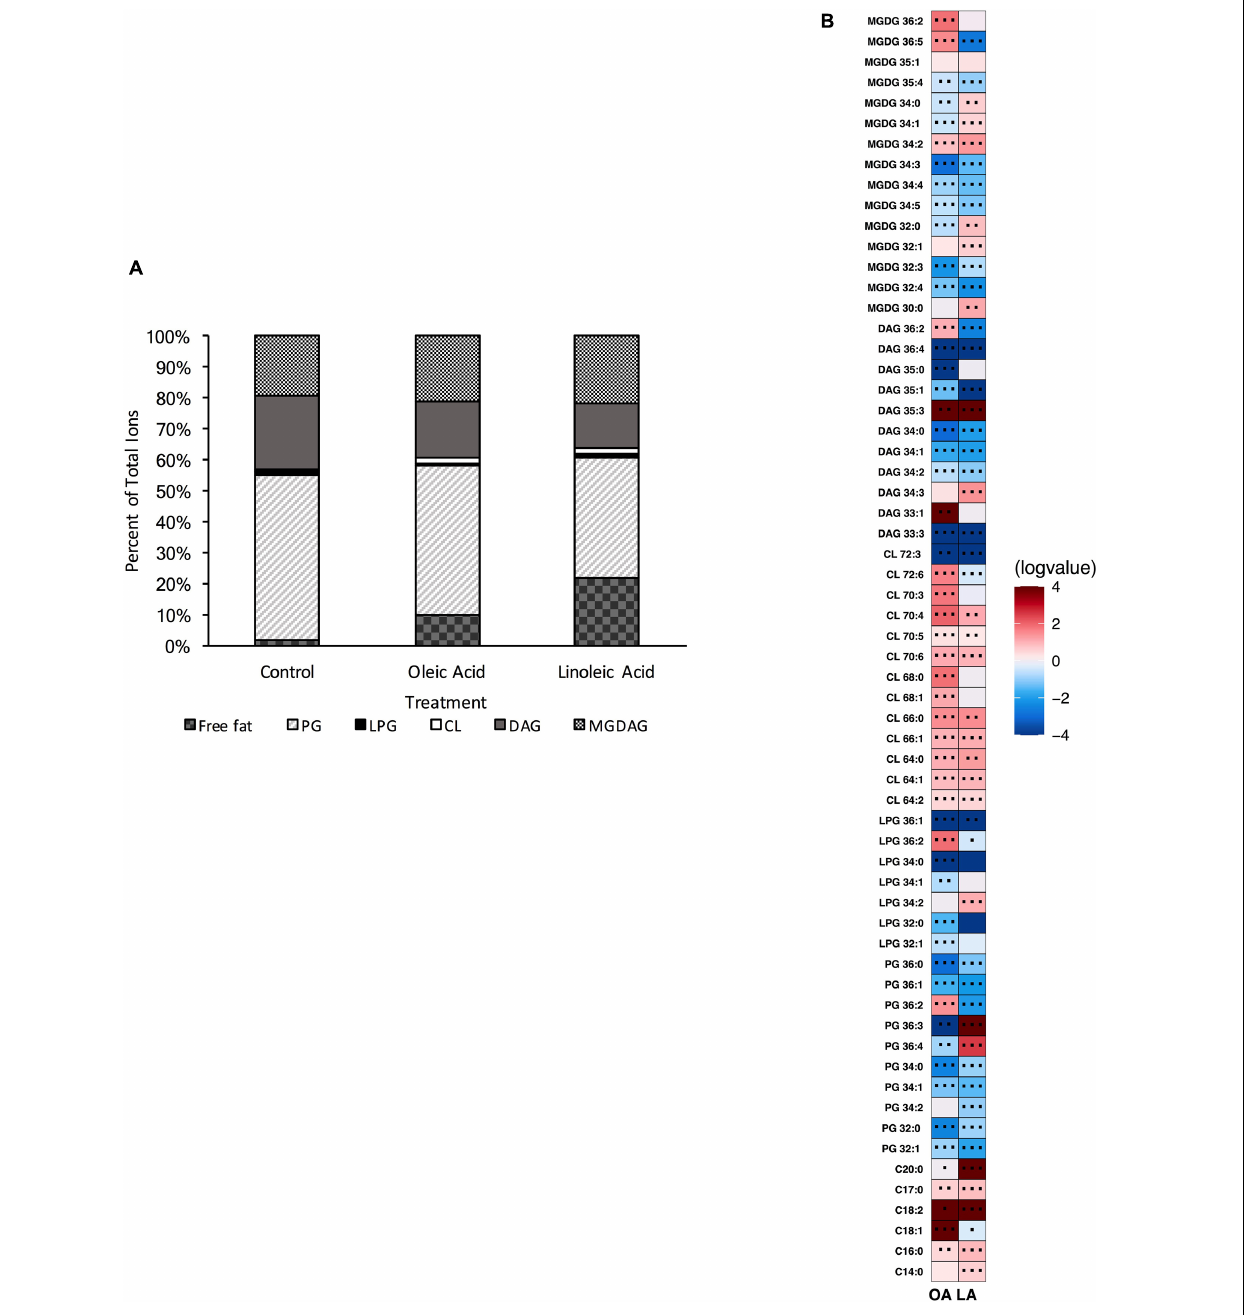
( Supplementary Table 4 ; 24% of total fatty acids detected via this method). While there was an increase in specific cardiolipin species upon linoleic acid supplementation, these species (CL